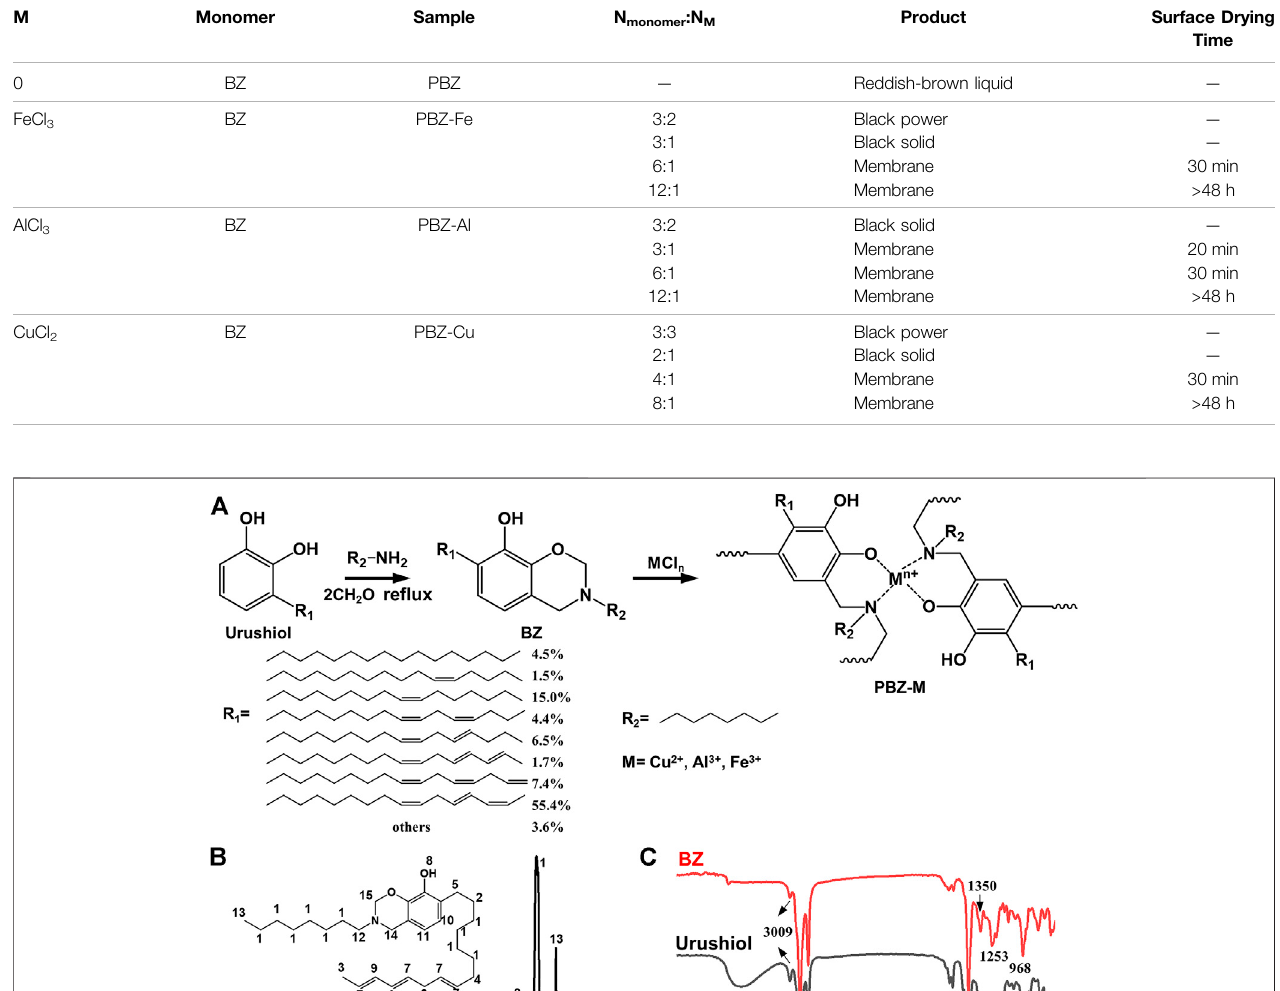
Frontiers in Chemistry |